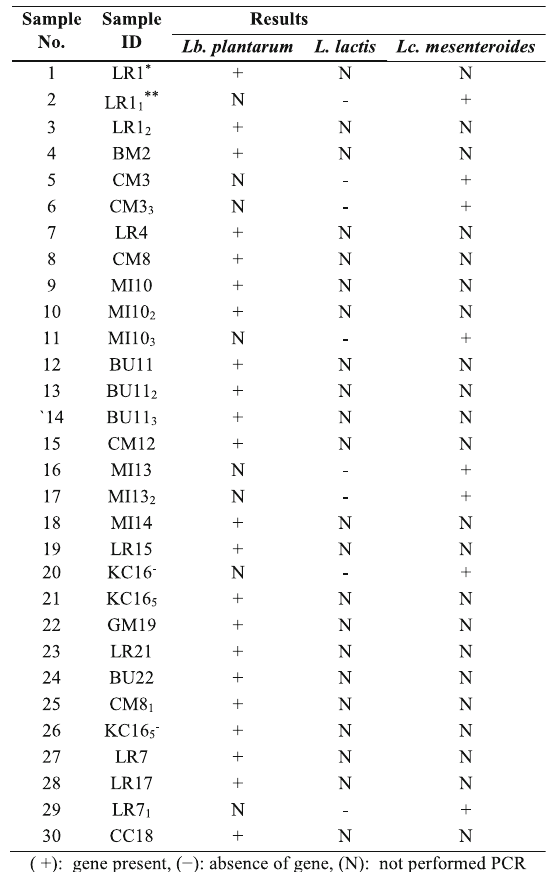
Table 4 Molecular identification of lactic acid bacterial isolates by using species-specific